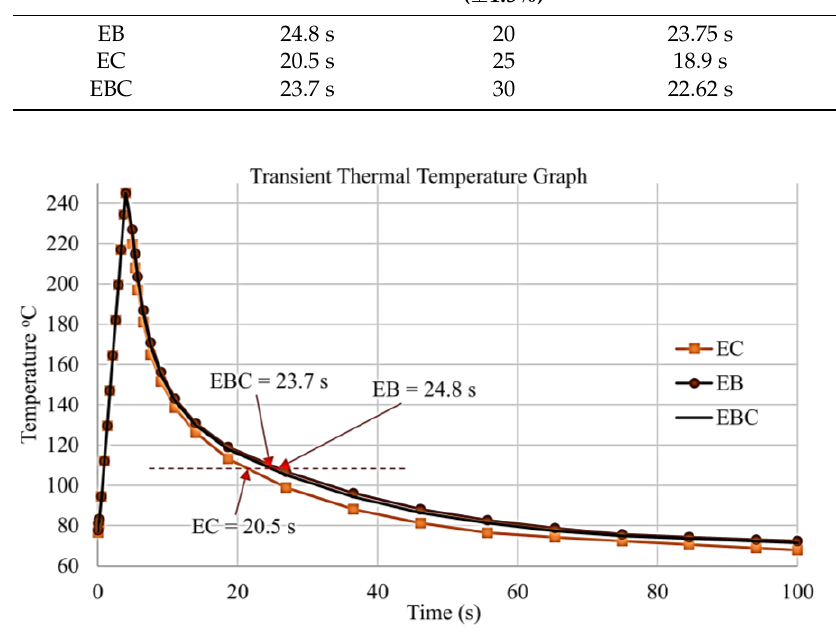
Figure 21. Transient thermal analysis graph at high compressive strength.